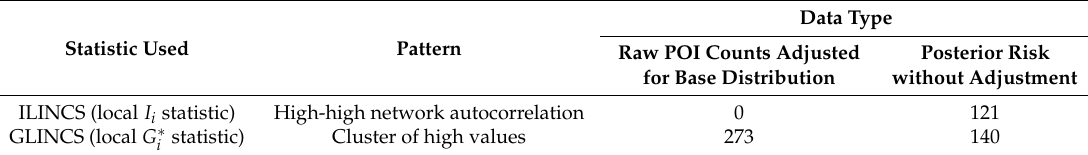
Table 4. Number of BSUs with significant high-high autocorrelation (local I i ) and high value concentration (local G ∗ ) (0.001 significance i